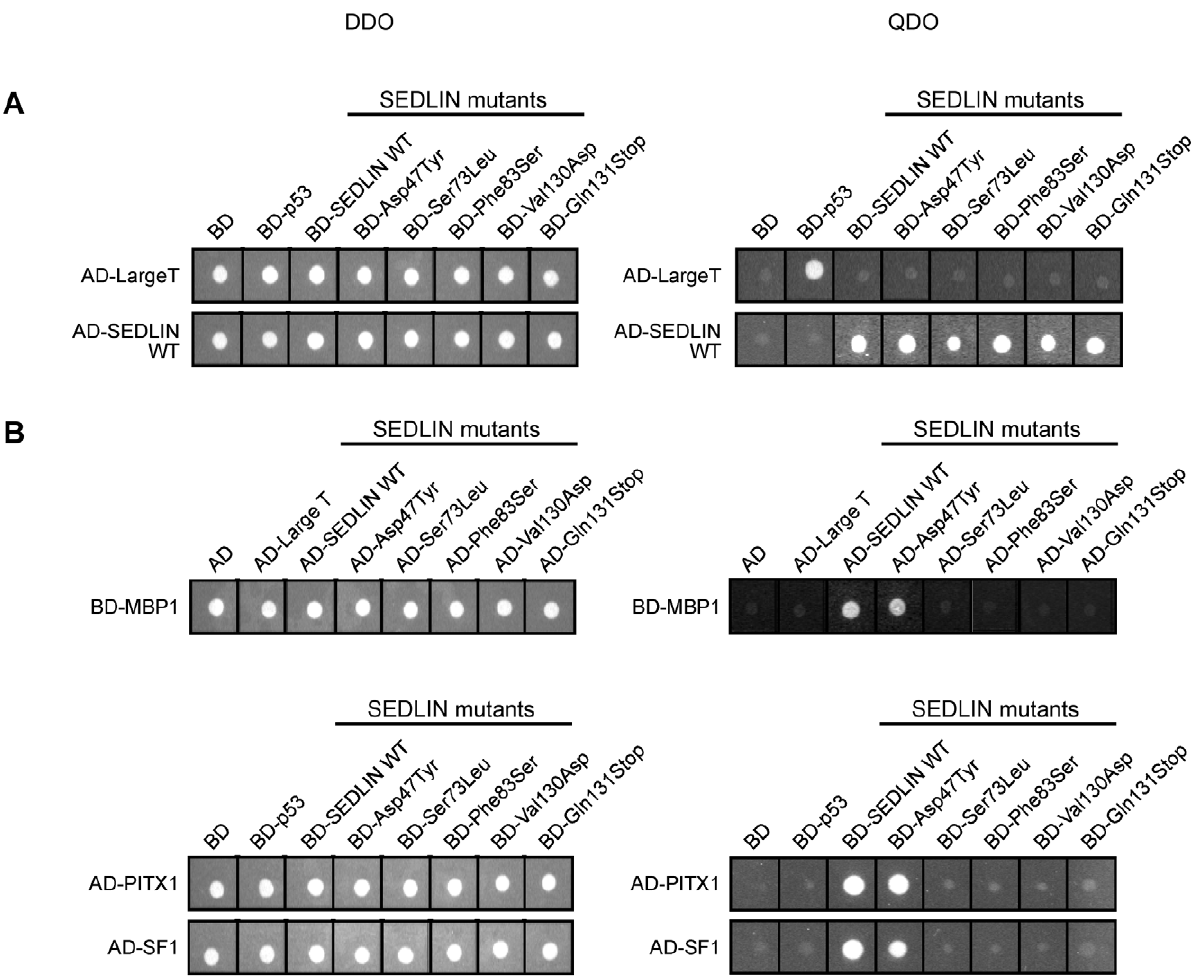
Figure 7. Interactions between SEDLIN, MBP1, PITX1 and SF1 using the yeast two-hybrid assay. Yeast cells, which do not have endogenous expression of SEDLIN, were used to investigate the interactions of wild-type or mutant SEDLIN (Asp47Tyr, Ser73Leu, Phe83Ser, Val130Asp and Gln131Stop) with wild-type SEDLIN, MBP1, PITX1 or SF1. The yeast reporter strain AH109 was used, and p53 and the SV40 large T antigen, which are known to interact [27], were used as a positive control. The yeasts were transformed with the vectors containing: (A) wild-type SEDLIN in pGADT7-AD (AD-WT) and either wild-type or mutant SEDLINs in pGBKT7-BD (BD-WT, BD-Asp47Tyr, BD-Ser73Leu, BD-Phe83Ser, BD- Val130Asp or BD-Gln131Stop). (B) wild-type and mutant AD-SEDLINs or BD-SEDLIN and each of the transcription factors BD-MBP1, AD-PITX1, AD-SF1. Yeast growth was monitored for 48 hrs after spotting and incubation at 30 u C using either double drop out, DDO (Leu - Trp - ), media as a control or quaternary drop out, QDO (Leu - Trp - Ade - His - ), media in which the growth is dependent on the physical interaction between BD-SEDLIN and AD- transcription factors, or AD-SEDLIN and the BD-transcription factor. The wild-type SEDLIN interacts with wild-type SEDLIN and all of the mutant SEDLIN proteins, consistent with the proposed model for the formation of homodimers. However, the MBP1, PITX1 and SF1 fusion proteins, which interact with the wild-type SEDLIN, interacted only with the mutant Asp47Tyr SEDLIN, but not with the mutant Ser73Leu, Phe83Ser, Val130Asp and Gln131Stop